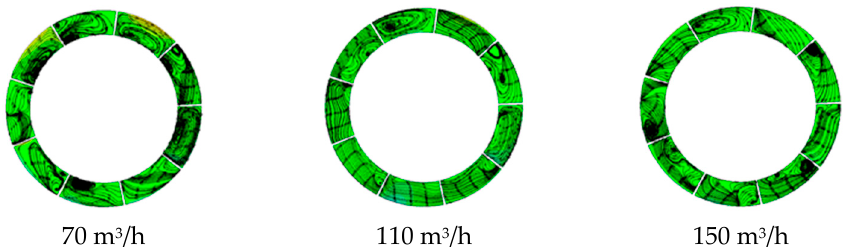
Figure 17. The streamline distribution of the middle section of the outlet section of the first static impeller.